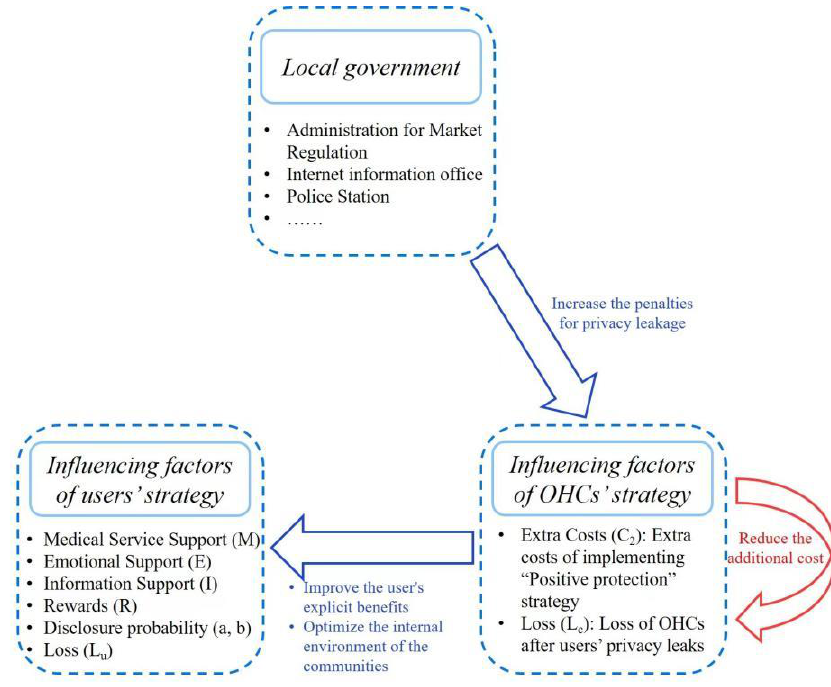
Figure 6. Policy implications and practical suggestions from the